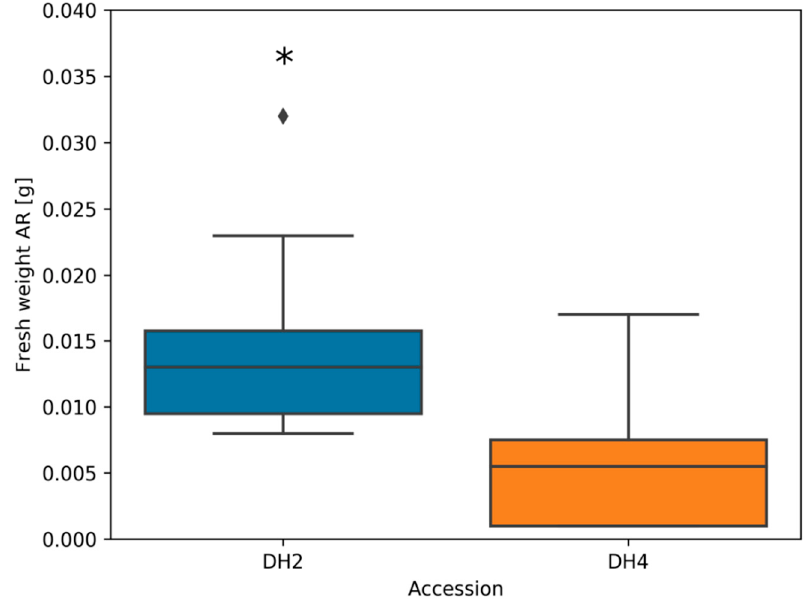
Figure 4. Mass of adventitious roots determined after 7 days of waterlogging in DH2 and DH4 cucumber accessions. Asterix indicates significant differences between accessions ( n = 10) according to Student’s t -test ( p < 0.05). The diamond represents the outlier.